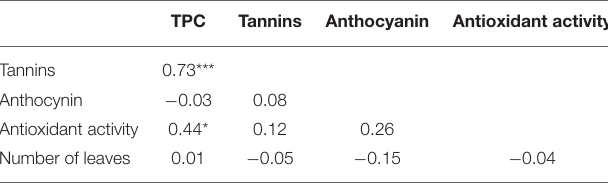
TABLE 3 | Spearman rank phenotypic correlation between phytochemicals and number of leaves of 33 accessions of Gynandropsis gynandra